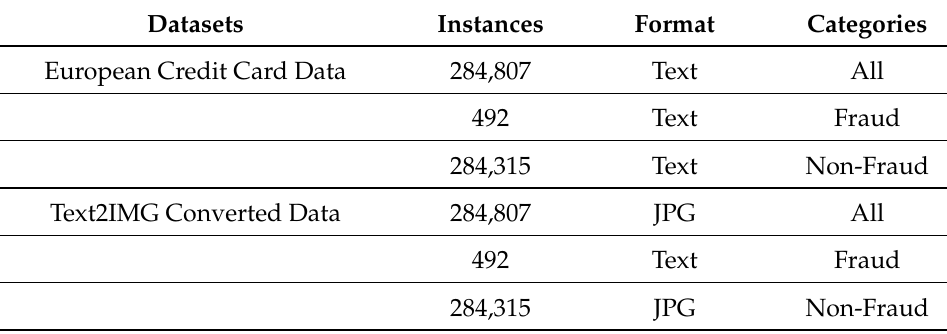
Table 3. Input data before and after